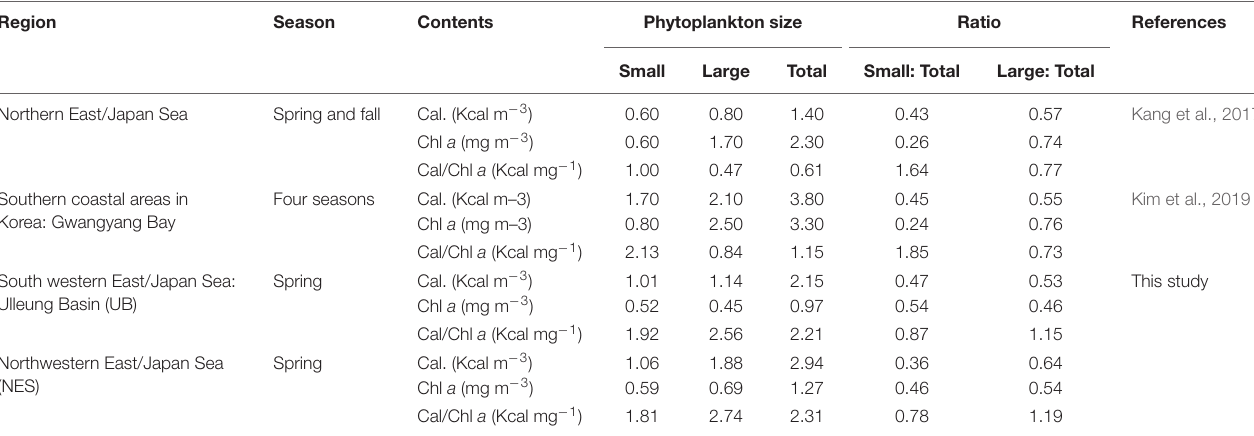
TABLE 3 | Comparison of Cal/chl ratios between small and large phytoplankton.